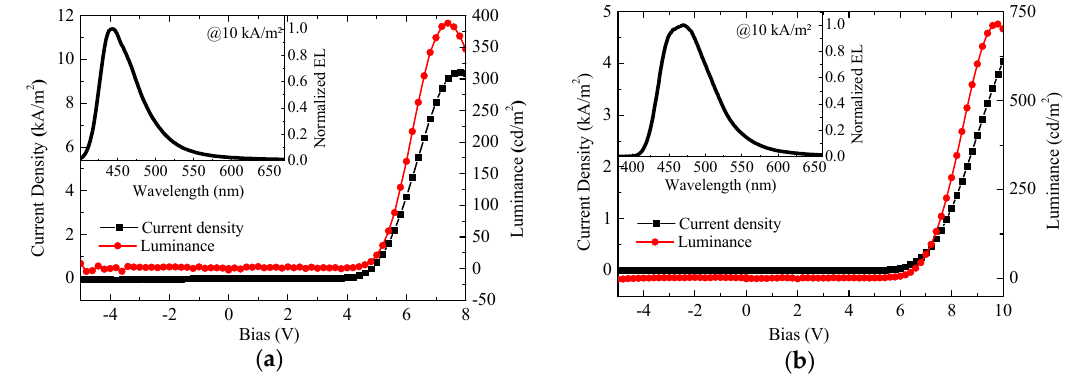
Figure 8. Voltage-current-luminance characteristics of D1 ( a ) and PYNPA ( b ) in single-layer devices (inset: the electroluminescence spectra).